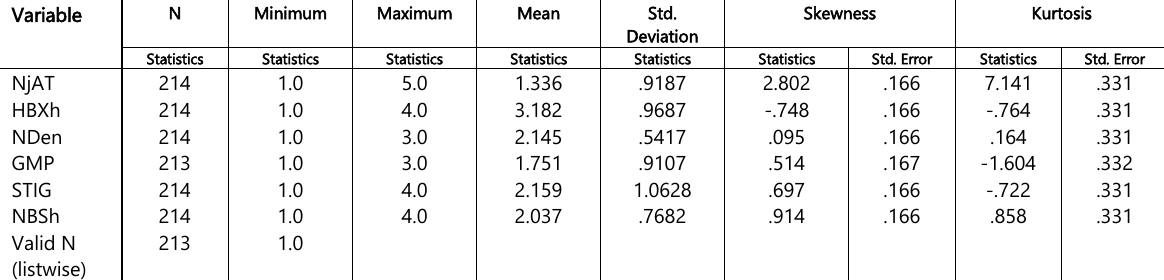
Table 8: Descriptive Statistics (Source: Authors’